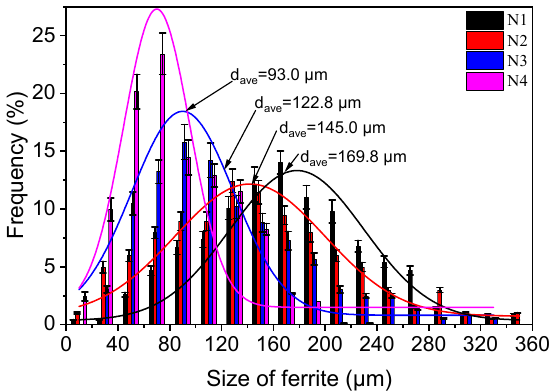
Figure 3. Size distribution of ferrite grains in the four kinds of cast ingot.